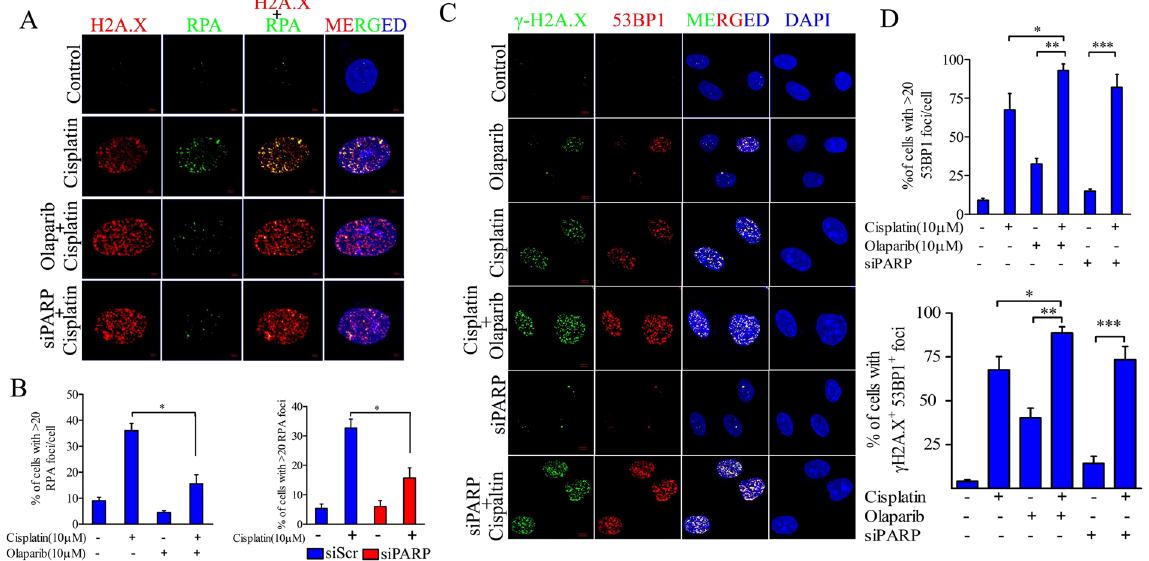
Figure 5. PARP1 inhibition stalls replication fork and induces DSBs. ( A ) Representative immunofluorescence of RPA and γ H2A.X foci in cisplatin and/or olaparib treated cell CC cell lines along with PARP1 silenced cell treated with cisplatin. ( B ) Quantification of percentage of cells with > 20 RPA foci/cell in indicated treatment groups (cisplatin vs . cisplatin + olaparib and PARP1 siRNA vs . PARP1 siRNA + cisplatin * p < 0.05). ( C ) Representative immunofluorescence of 53BP1 foci and γ H2A.X foci in indicated treatment or siRNA transfection in CC cells. Cisplatin and olaparib both induce 53BP1 foci in CC cell line but combination of both drug or cisplatin treatment in PARP1 depleted cells produces higher number of 53BP1 foci and display more number of γ H2A.X foci which co-localizes with each other. ( D ) Quantification plot showing percentage of cells showing > 20 53BP1 foci in mentioned treatment groups and γ H2A.X + 53BP1 + cells in respective mentioned